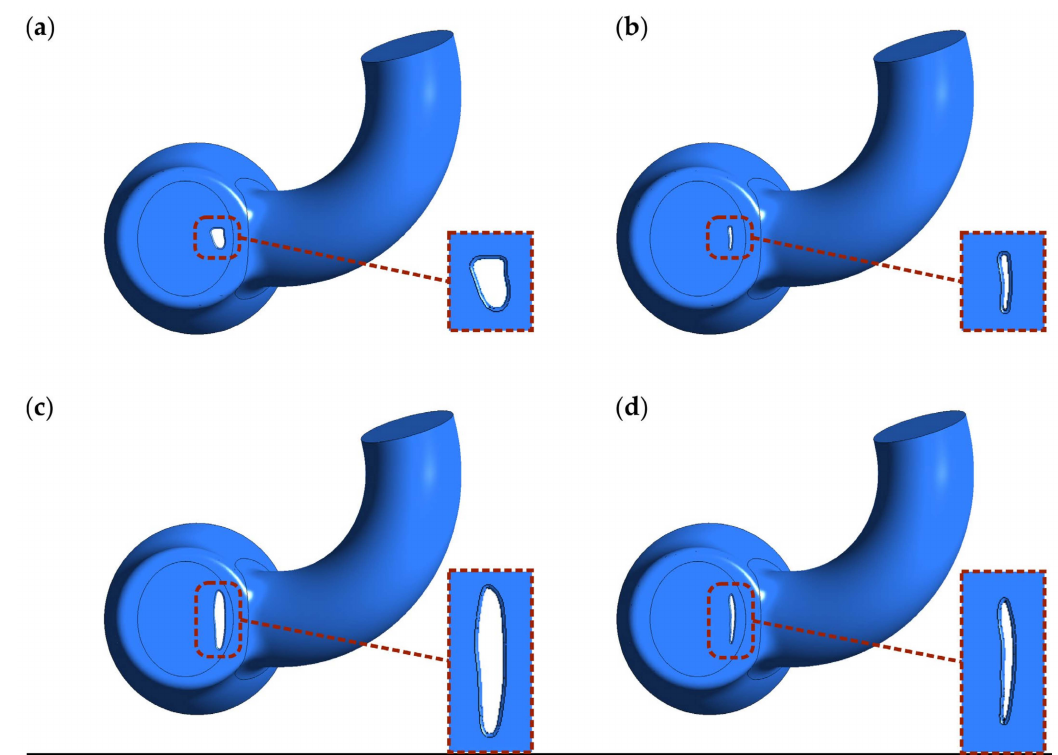
Figure 2. Shape and location of PVL channels around the mitral valve. Channel height: 3 mm. CSA: ( a ) 7.9 mm 2 ; ( b ) 1.5 mm 2 ; ( c ) 18.5 mm 2 ; ( d ) 5.0 mm 2 .